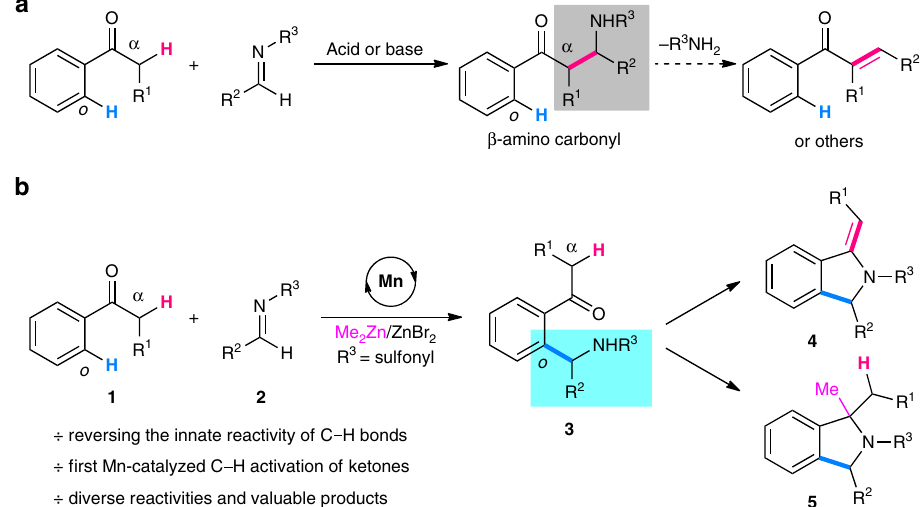
Fig. 1 Innate and reversed reactivity of C – H bonds in ketones with imines. a The classic Mannich reaction of innately reactive α -C(sp 3 ) – H bonds. b Mn- catalyzed ortho -C(sp 2 ) – H addition by reversing the reactivity of C – H bonds (this work) NATURE COMMUNICATIONS | 8: 1169 | DOI: 10.1038/s41467-017-01262-4 |